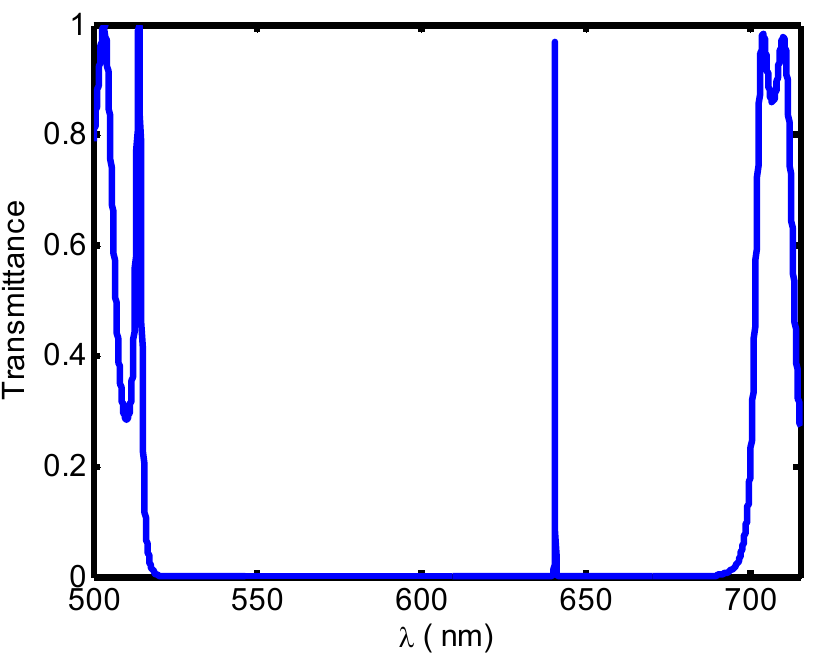
Figure 2. The transmission spectra of the proposed 1D biophotonic sensor loaded with a water sample having cavity thickness 200 nm at normal incidence.